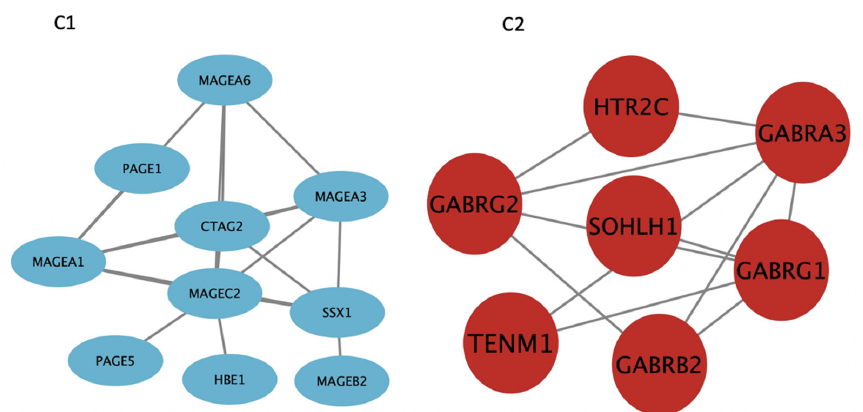
Figure 6. String was used to detect predictive interactions between the top fold change genes from the royal blue module. K-means clustering algorithm was used to cluster the genes based on the biological functions. Genes denoted with aqua blue ( C1 ) nodes are mainly from the MAGE (Melanoma Antigen Gene) family of genes. Genes clustered with red nodes ( C2 ) are mainly from the Gamma-aminobutyric acid receptor genes, which are major inhibitory neurotransmitters in the mammalian brain. To change the size and color of each node, we uploaded the clustered genes into Cytoscape.